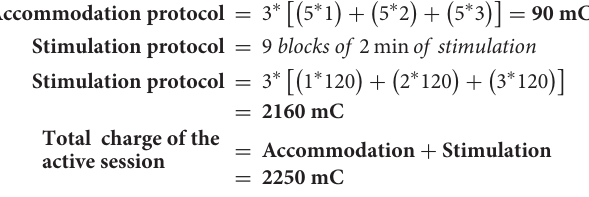
Stimulation protocol = 9 blocks of 2min of